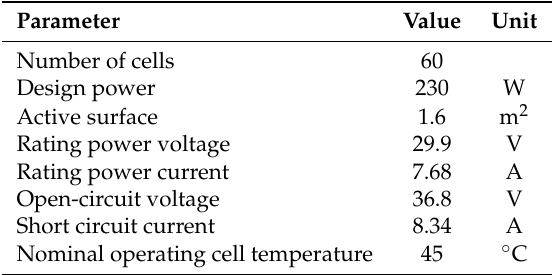
Table 7. PV module technical data. Values are 25 ◦ C, a solar irradiance equal to 1000 W/m 2 , and an air mass coefficient of 1.5.